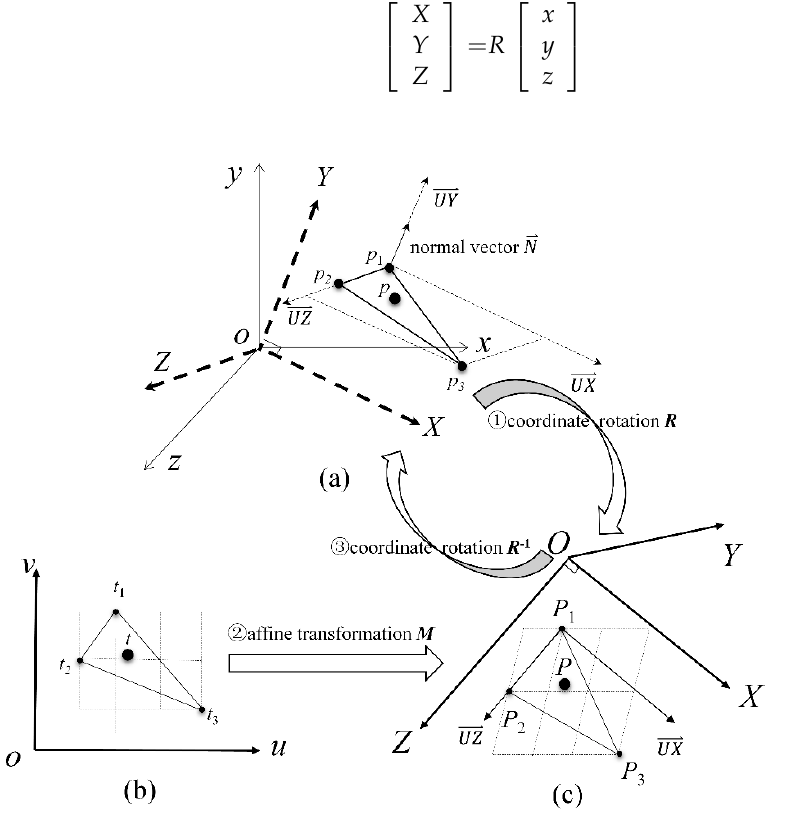
Figure 4. Schematic diagram of the process of converting 2D texture coordinates to 3D model coordinates. ( a ) 3D coordinate system. ( b ) Texture coordinate system. ( c ) Local 3D coordinate